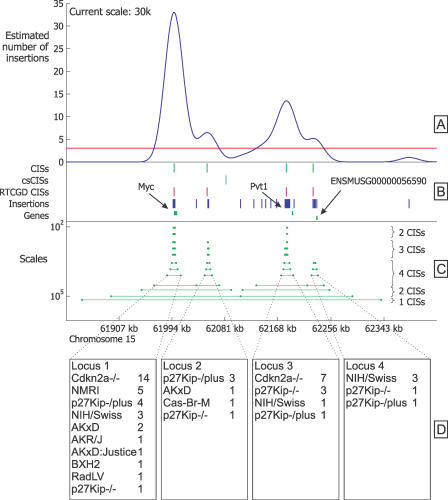
The Myc Locus on Chromosome 15(A) The blue line represents the estimated number of insertions as a function of position for a certain region. The red line depicts the threshold associated with an α-level of 0.05.(B) CISs are depicted by means of vertical lines. From top to bottom these represent: the CISs for the current scale (30k), the csCISs, the CISs from the RTCGD, the insertions, and the genes (top and bottom strand separated).(C) Scale space diagram. The vertical axes of the scale space has a logarithmic scale and indicates the scale for which the CIS was detected (only a subset of scales was actually evaluated: [50 100 250 500 1 k 2.5 k 5 k 10 k 30 k 50 k 100 k 150 k] bp).(D) Evaluation of the insertion distribution over four small scale CISs, identified by scale space analysis. Per screen we list the number of insertions that fall within the small scale CIS. The screens are labeled consistent with RTCGD nomenclature.